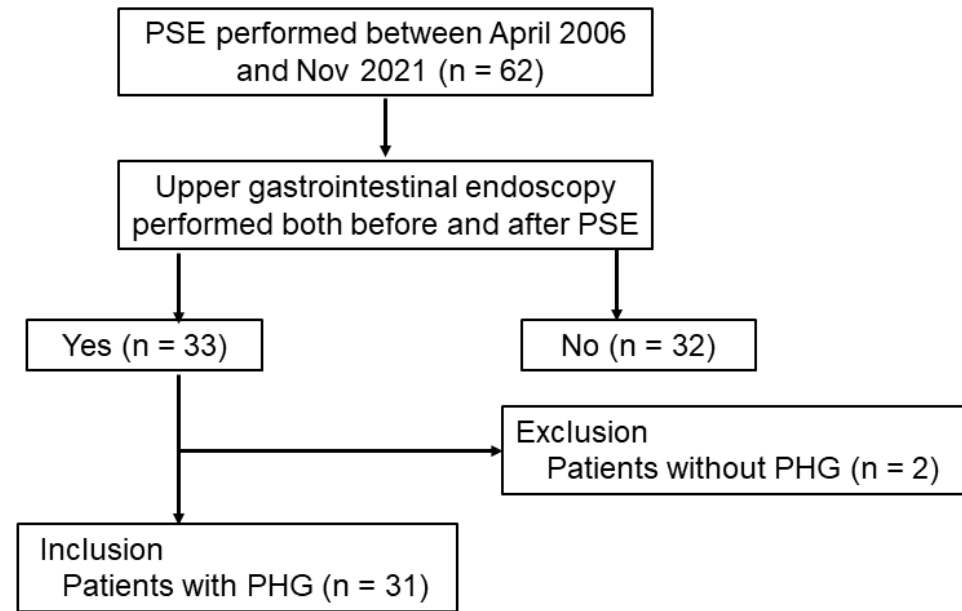
Figure 1. Study design and inclusion and exclusion criteria for partial spleen embolization.